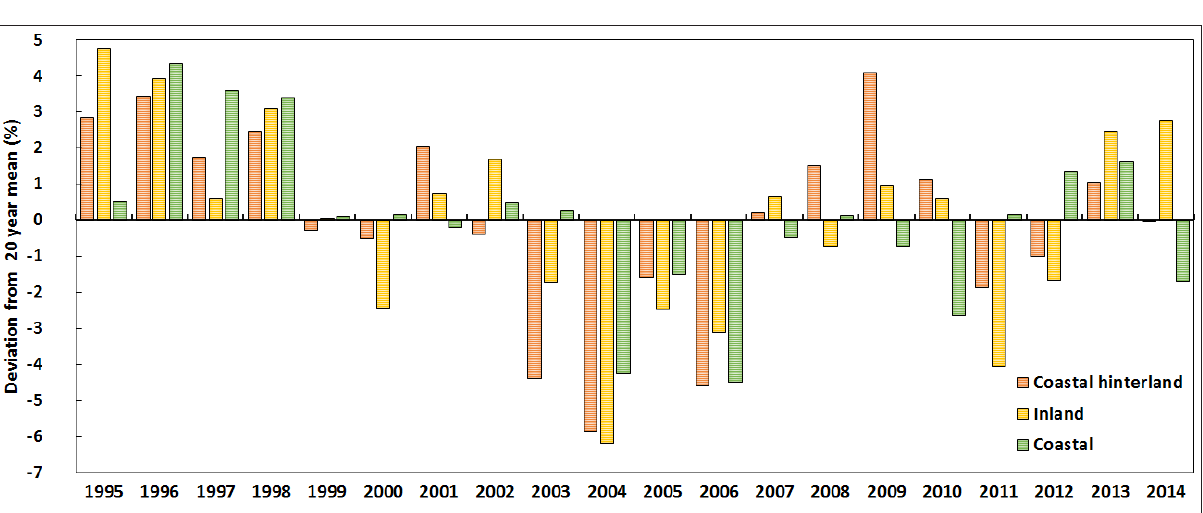
Figure 2: Mean annual wind speed variance per zone, based on mean annual short-term trends between 1995 and